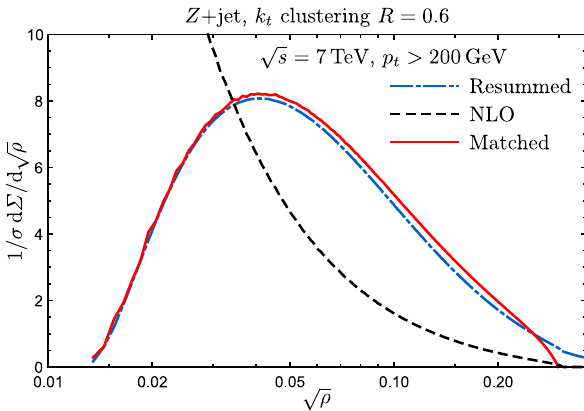
Fig. 13 Matched differential jet mass distribution with k t clustering compared to MCFM NLO fixed-order